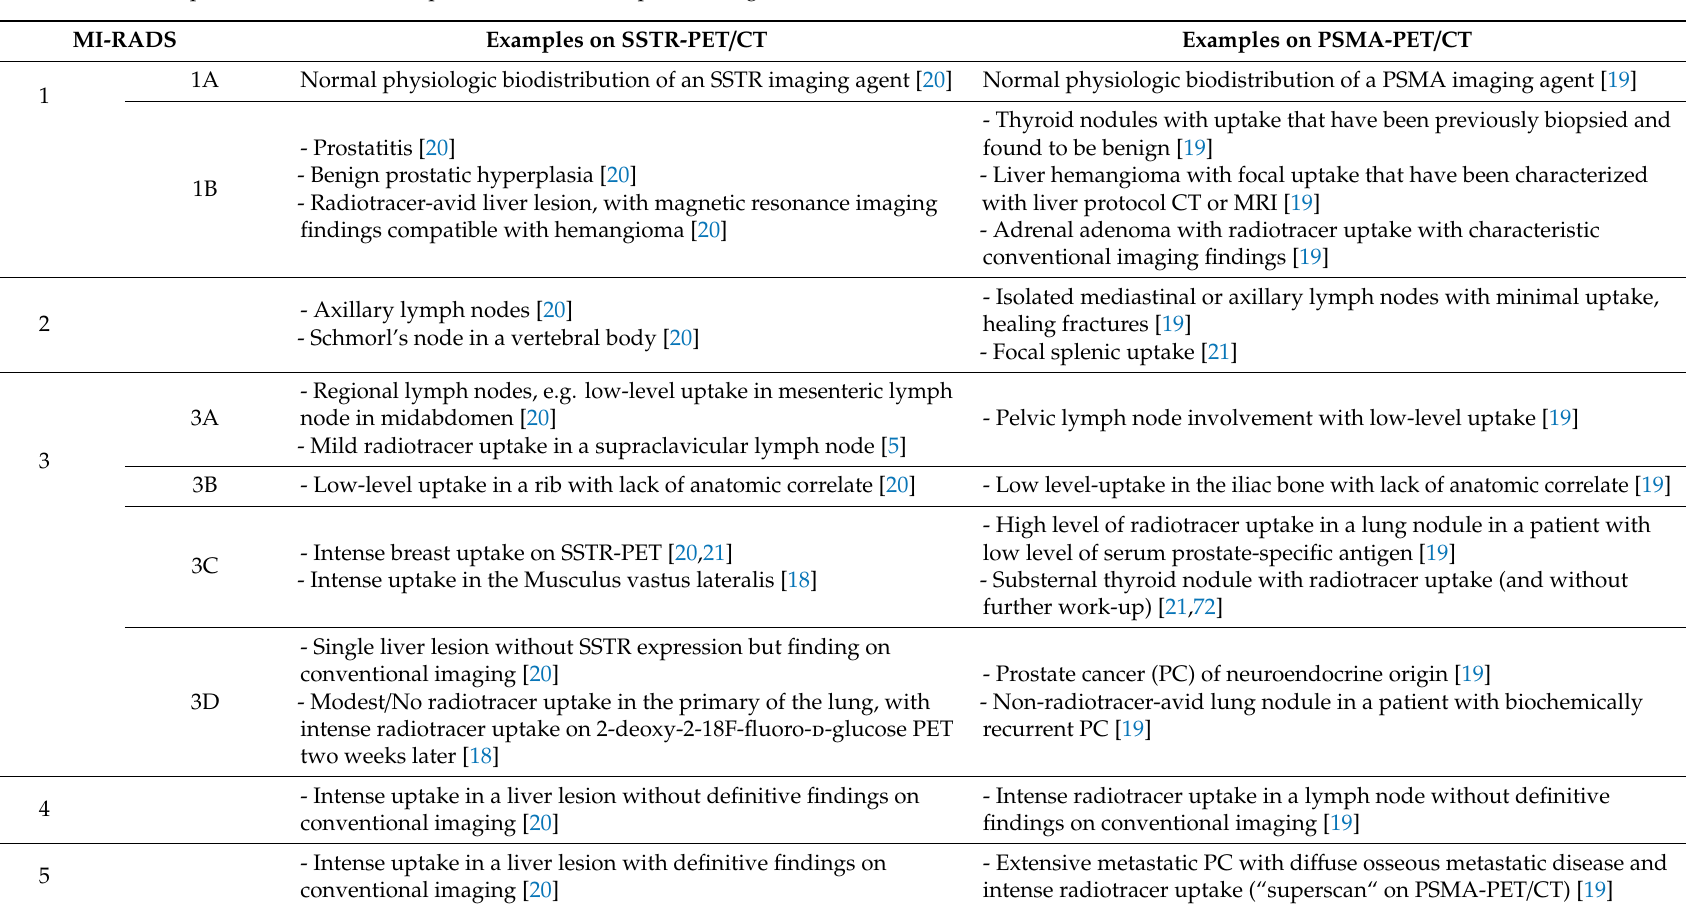
Table 2. Common examples for all classifications, as described in the literature to date. Reporting and data systems (RADS) in molecular imaging (MI-RADS), somatostatin receptor (SSTR)-RADS, and prostate-membrane specific antigen